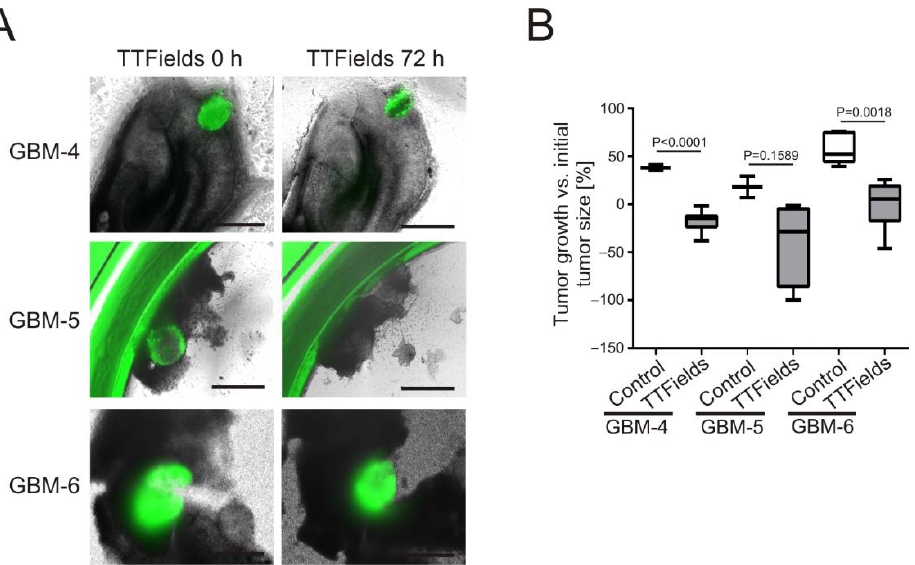
Figure 5. Patient-derived GBM-organoid size is reduced by TTFields treatment. ( A ) Comparison of different patient-derived GBM organoids grown on organotypic hippocampal slice cultures (OHSC) before (TTFields 0 h) and after treatment with TTFields at 200 kHz for 72 h (TTFields 72 h). Organoids were visualized by fluorescence microscopy (green). Shown are representative images of n = 6. Scale bar = 250 µm. ( B ) Quantification of the organoid-growth on OHSC. A minimum of three and up to six, organoids were measured. For clinical details of the patient-derived organoids refer to Table 1.